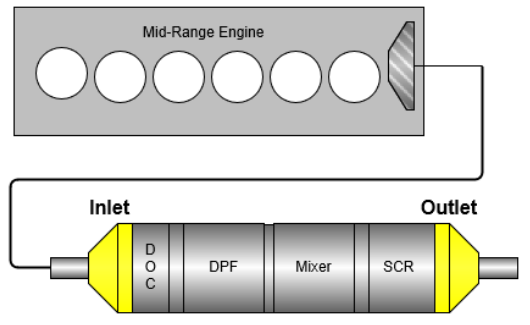
Figure 11. Test set-up for emission test.